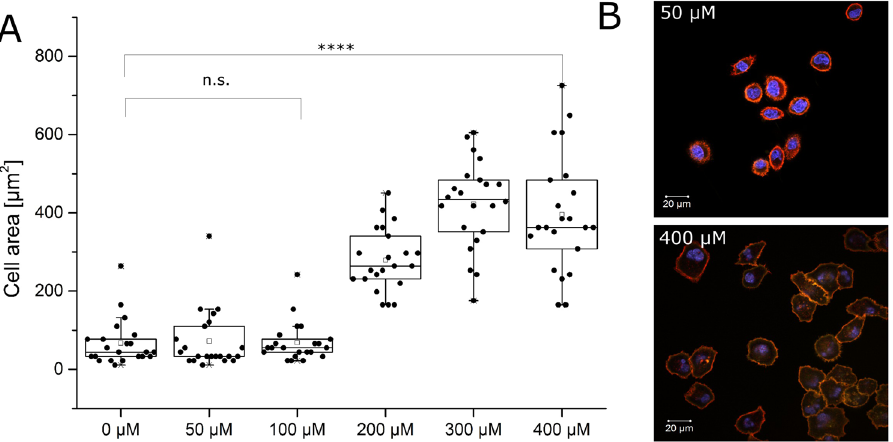
Figure 2. Lectin-mediated cell adhesion. ( A ) 2 * 10 5 cells were seeded onto a hydrogel surface in the absence or presence of different YFP-LecB concentrations from 0 to 400 µ M. Cells could adhere to the surface in the presence of cell culture medium for 24 h, followed by staining of cell cytoskeleton (red phalloidin-rhodamine) and nucleus (blue DAPI). Cellular surfaces were analysed with confocal laser scanning microscopy. Adhesion was detected for YFP-LecB concentration of 300 µ M and higher. ( B ) Typical A549 cells in the presence of 50 and 400 µ M of YFP-LecB. All bars represent the standard deviation. The significance was tested with a one way anova with alpha = 0.05.